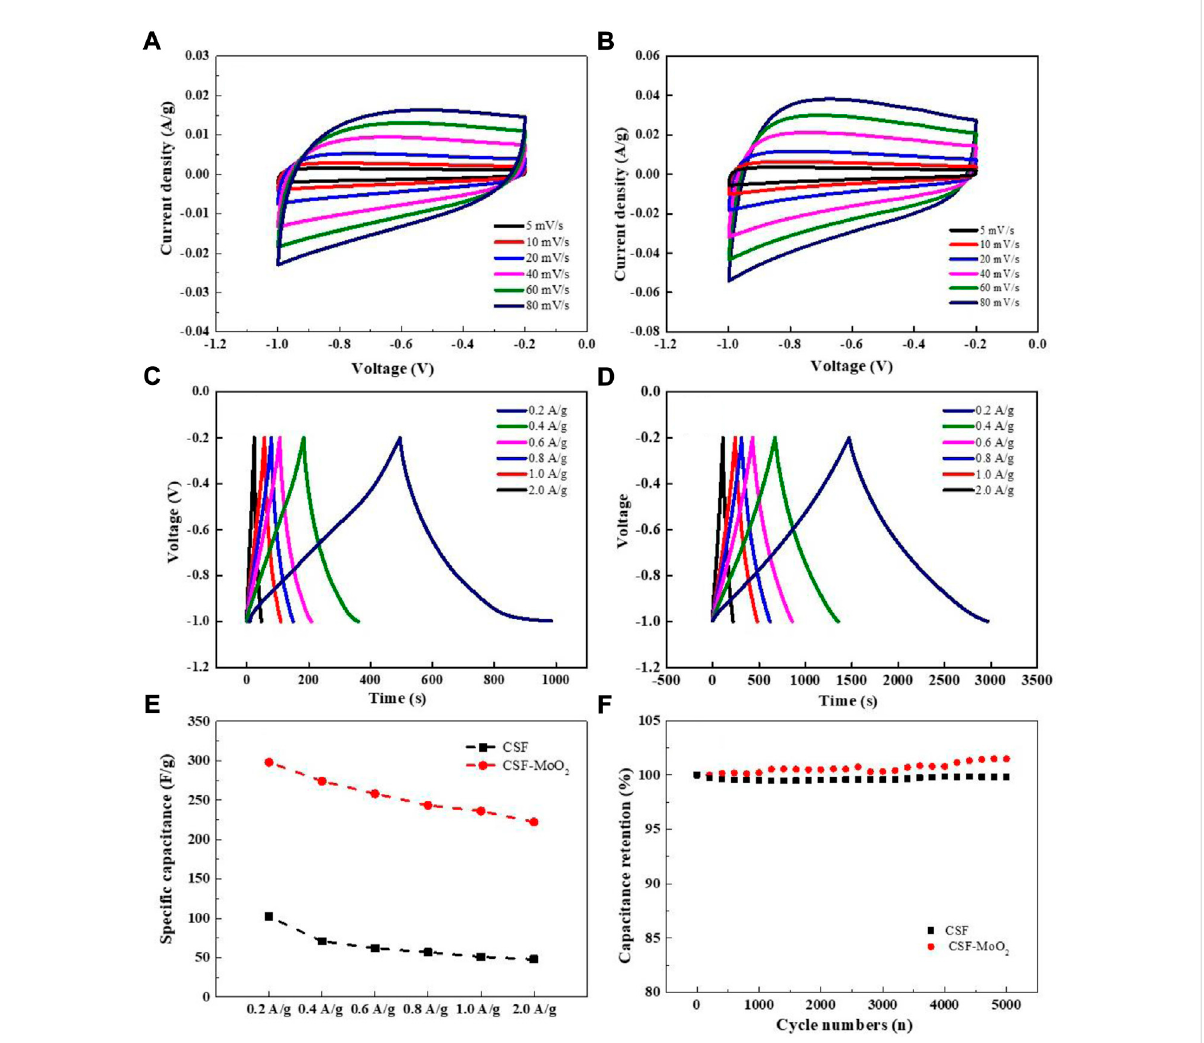
Capacitance characterization of electrode prepared from the carbonized silk. CV curves of (A) CSF and (B) CSF-MoO 2 electrodes at different scan rates. GCD curves generated at current densities of 0.2 – 2 A/g for (C) CSF and (D) CSF-MoO 2 electrodes. (E) Speci fi c capacitances of CSF and CSF-MoO 2 electrodes at different current densities. (F) Cycling stability of CSF and CSF-MoO 2 electrodes at a current density of 2